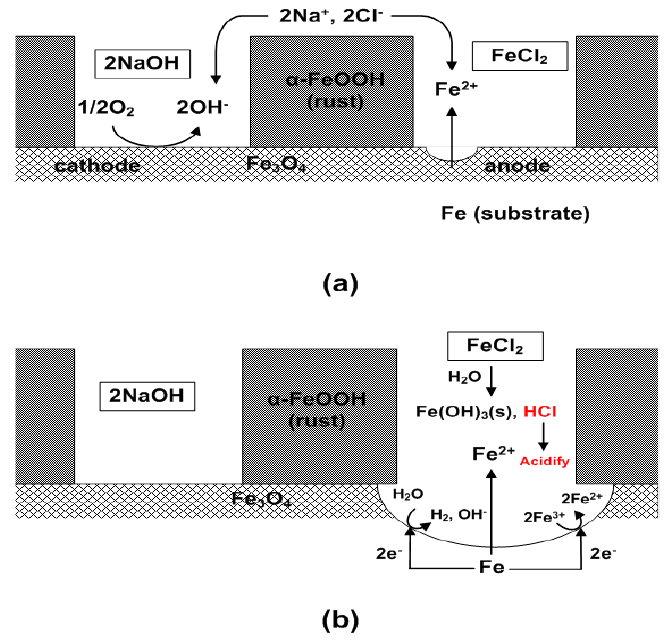
Figure 14. Mechanism of ( a ) crevice corrosion and ( b ) corrosion under the α -FeOOH rust.